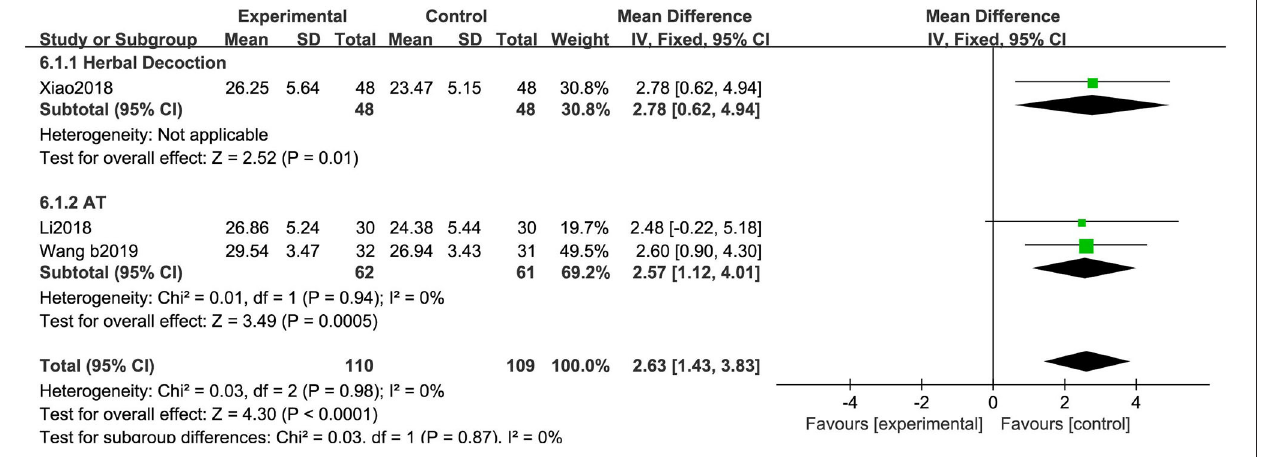
FIGURE 12 | Comparison of acupuncture related therapies in terms of